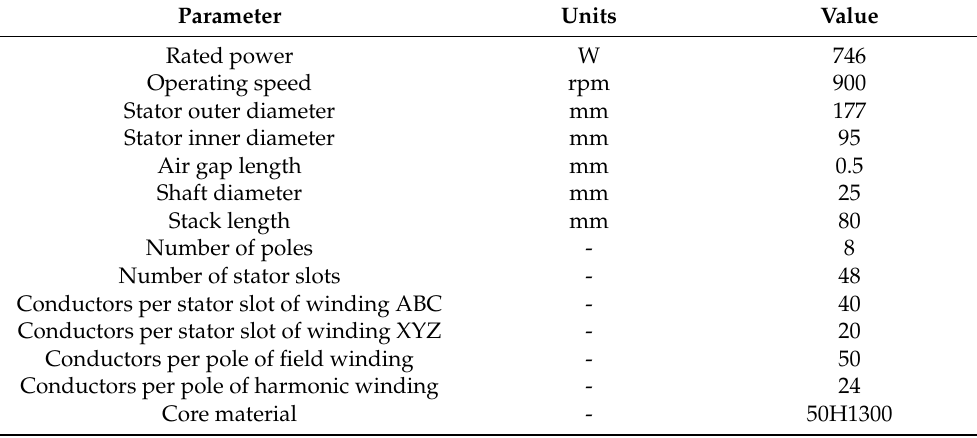
Table 1. Machine specifications for the brushless wound-rotor synchronous machine (BL-WRSM).